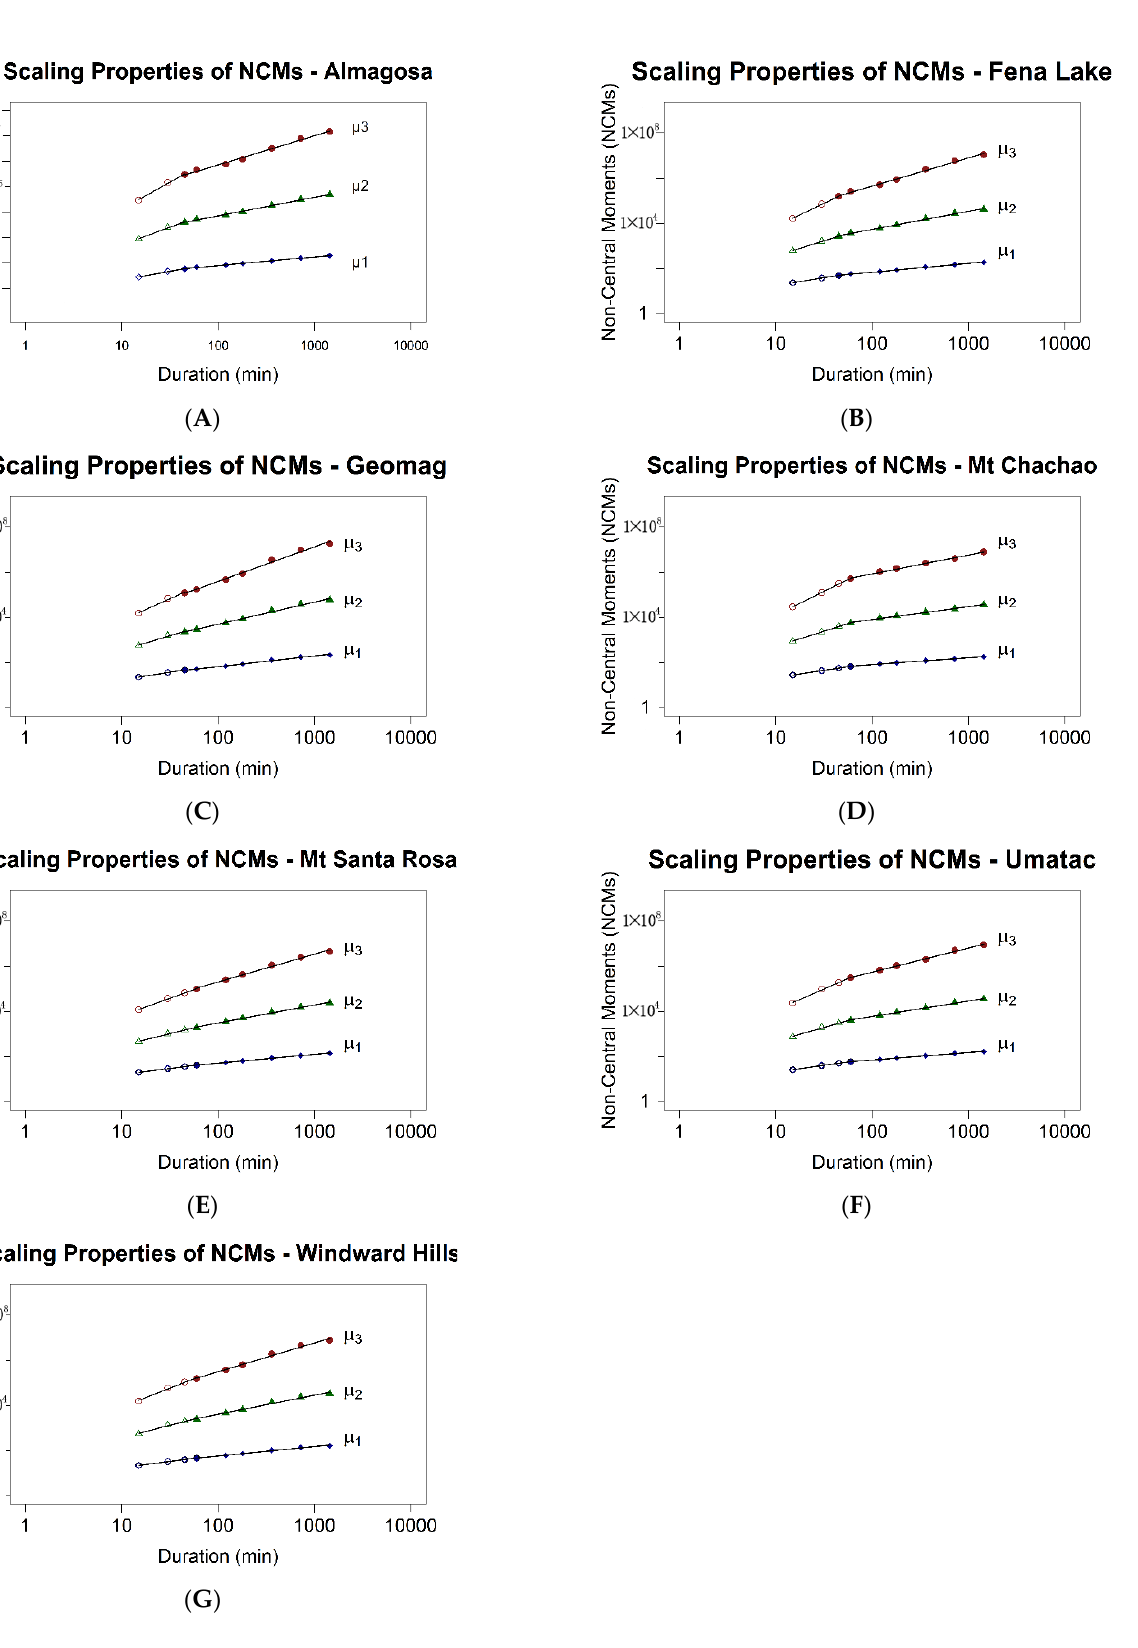
Figure 4. Scaling properties of AMPs. ( A ) is the NCM plot for Almagosa, ( B ) for Fena Lake, ( C ) for Geomag, ( D ) Mt. Chachao, ( E ) for Mt. Santa Rosa, ( F ) for Umatac, and ( G ) for Windward Hills,